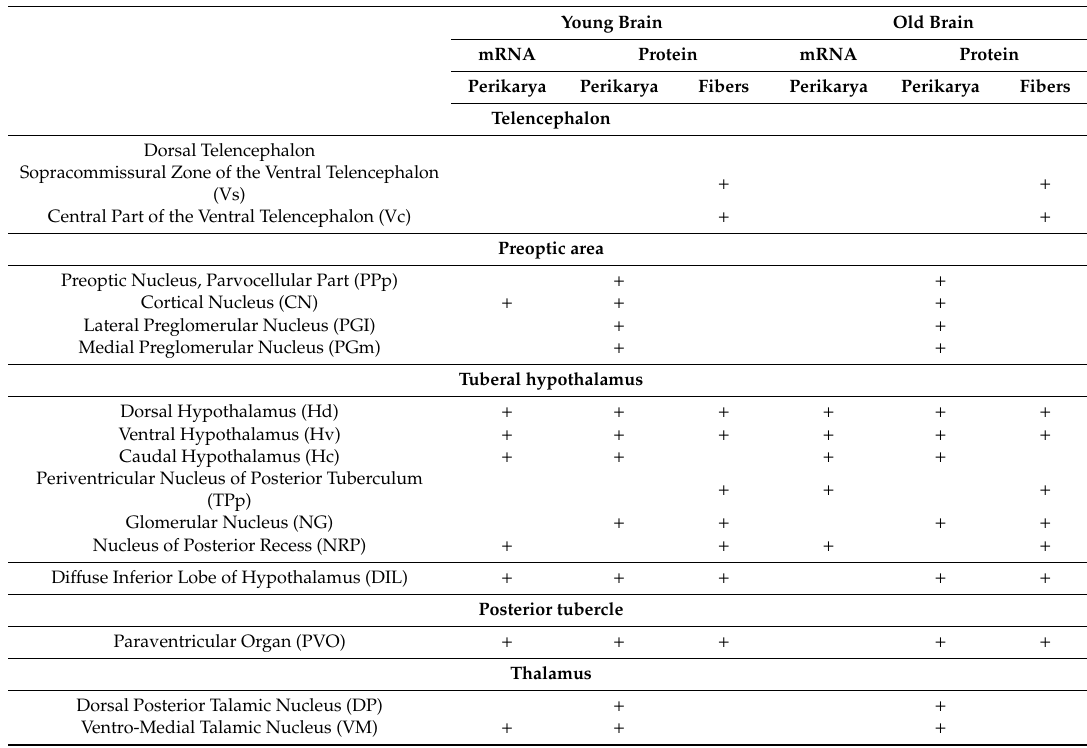
Table 1. Summary of positive perikarya and fibers localization of NUCB2B mRNA and Nesf-1 protein in the forebrain of young and old N. furzeri